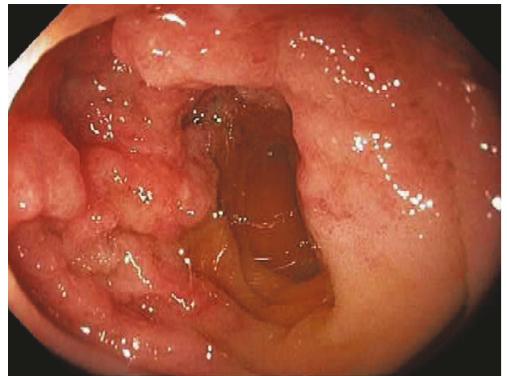
Figure 24: Endoscopic image of acute appendicitis. Figure 25: Endoscopic image of the terminal ileum during acute infectious ileocolitis. The mucosa is edematous, erythematous, and with prominent lymphoid